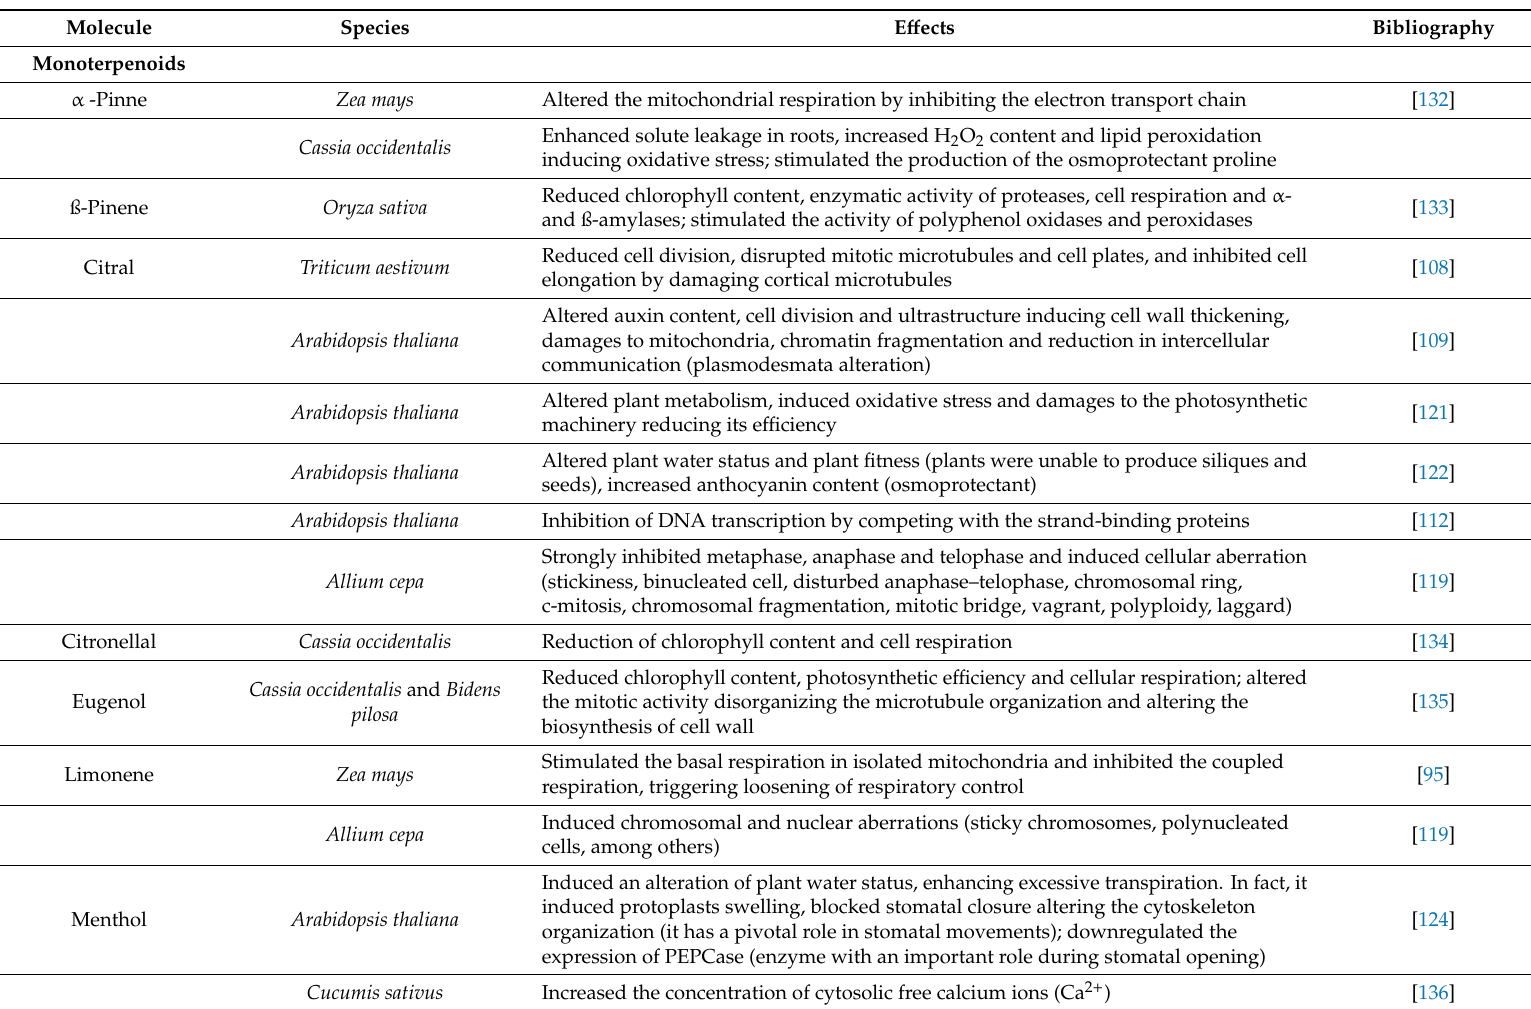
Table 2. E ff ects and metabolic targets of phytotoxic terpenoids on di ff erent species. Manuscripts focused on the screening of the phytotoxic potential of pure molecules, that reported only information of their e ff ects on germination or shoot and root growth parameters, were not included in the